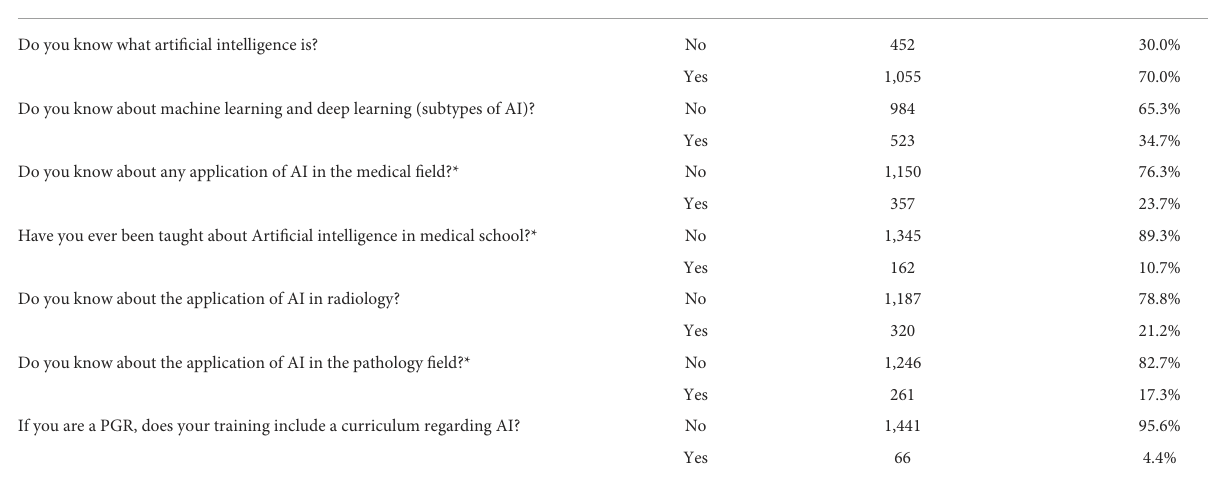
TABLE 2 Descriptive statistics for knowledge of artificial